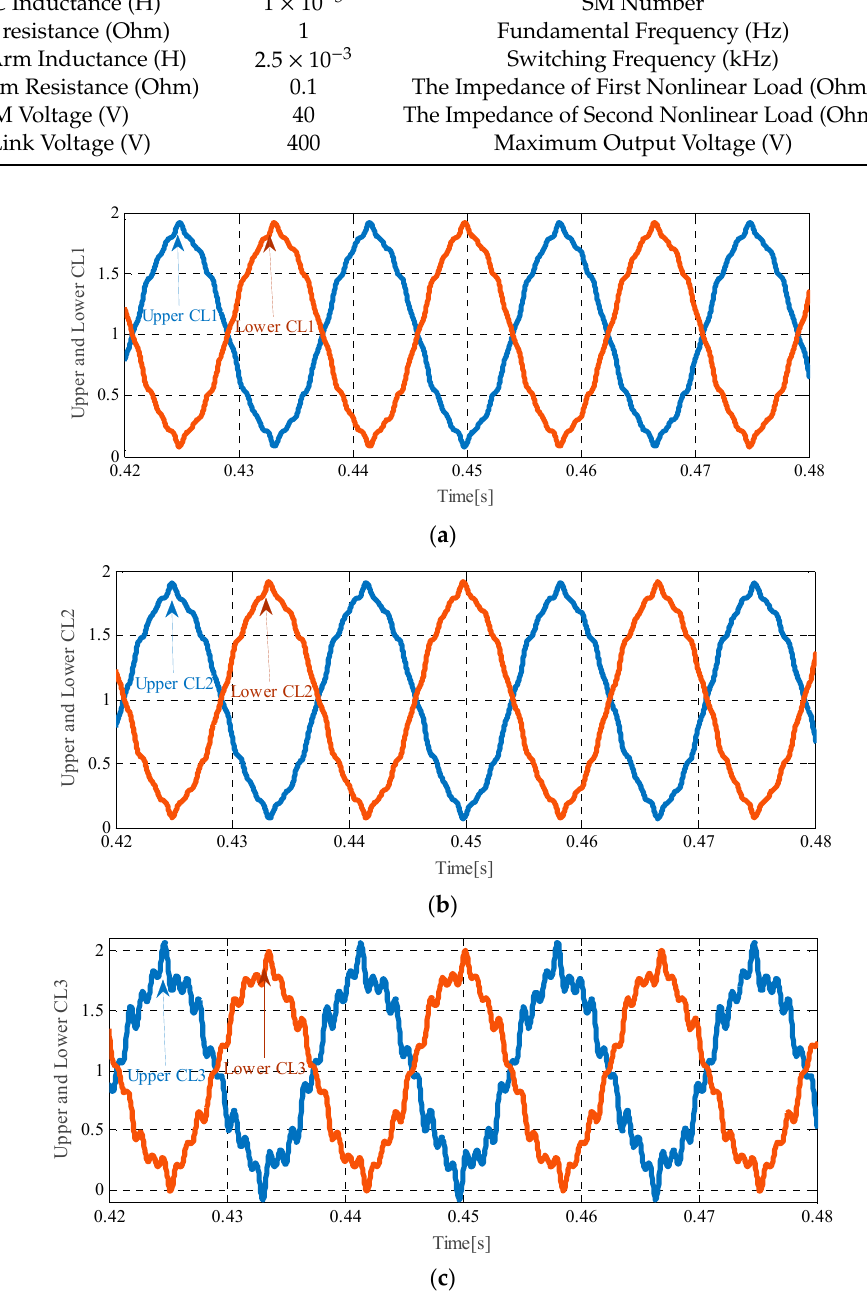
Figure 5. The proposed upper and lower control laws (CL) for the ( a ) first controller, ( b ) second controller, and ( c ) third controller. Table 1. The parameters of the proposed MMC in load change conditions.